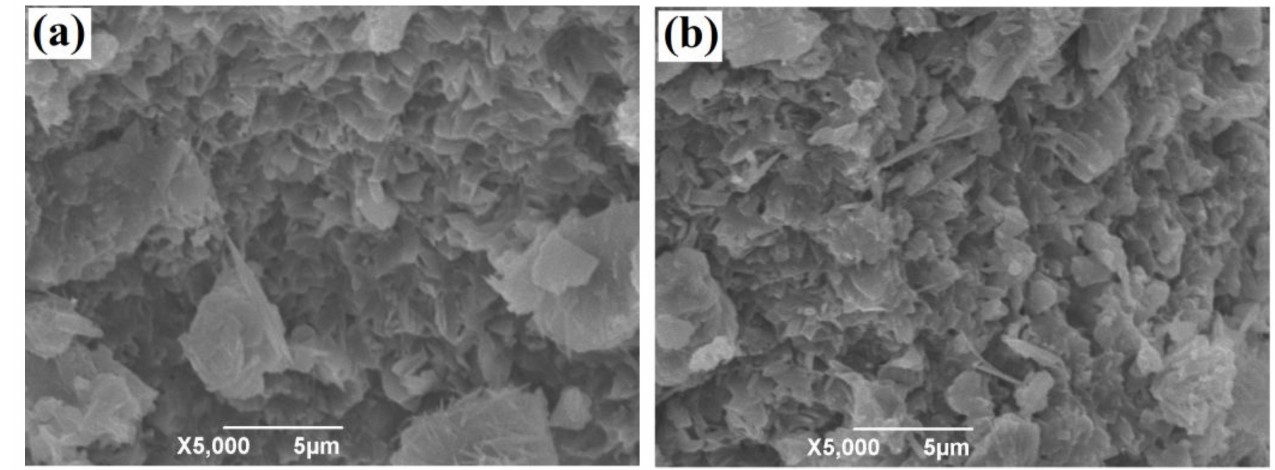
Figure 3. SEM images of ( a ) the MPC and ( b )